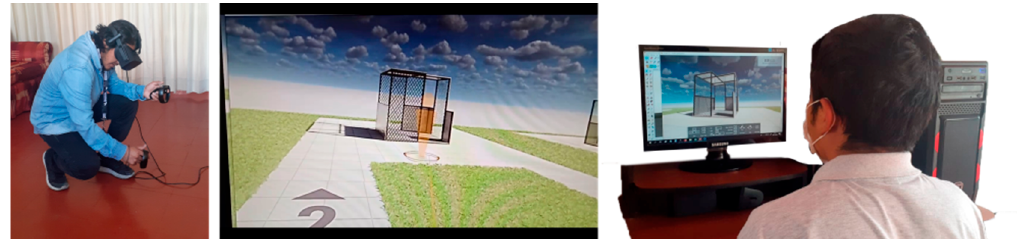
Figure 2. Example of VR uses.